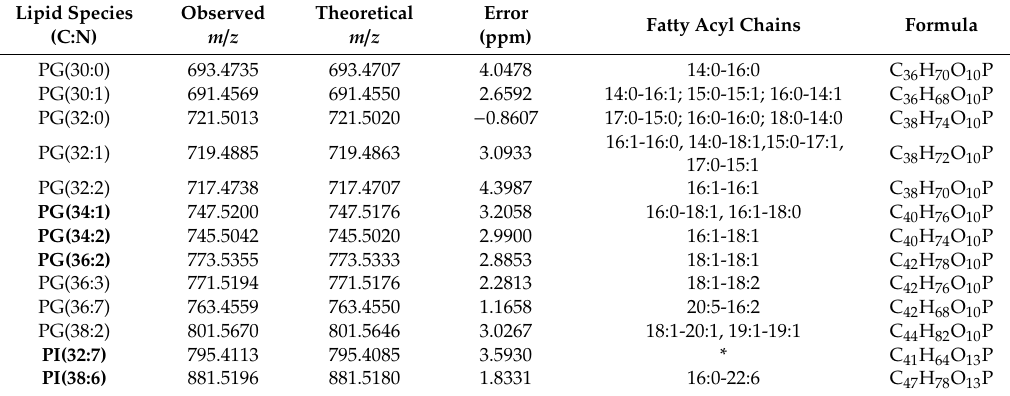
Table 6. Phospholipid species identified by liquid chromatography–mass spectrometry (LC–MS) in negative mode as [M – H] – ions (error < 5 ppm). Polar head groups and fatty acyl composition were confirmed by tandem MS (MS / MS) spectra of [M-H] − ions. The numbers in parentheses (C:N) indicate the number of carbon atoms (C) and double bonds (N) in fatty acyl chains. The most abundant species (relative abundance > 10%) are indicated in bold. Species identified only by retention time and mass accuracy are marked with an asterisk (*). PG, phosphatidylglycerol; PI, phosphatidylinositol. Lipid Species Observed Theoretical Error m / z m / z (C:N) (ppm)